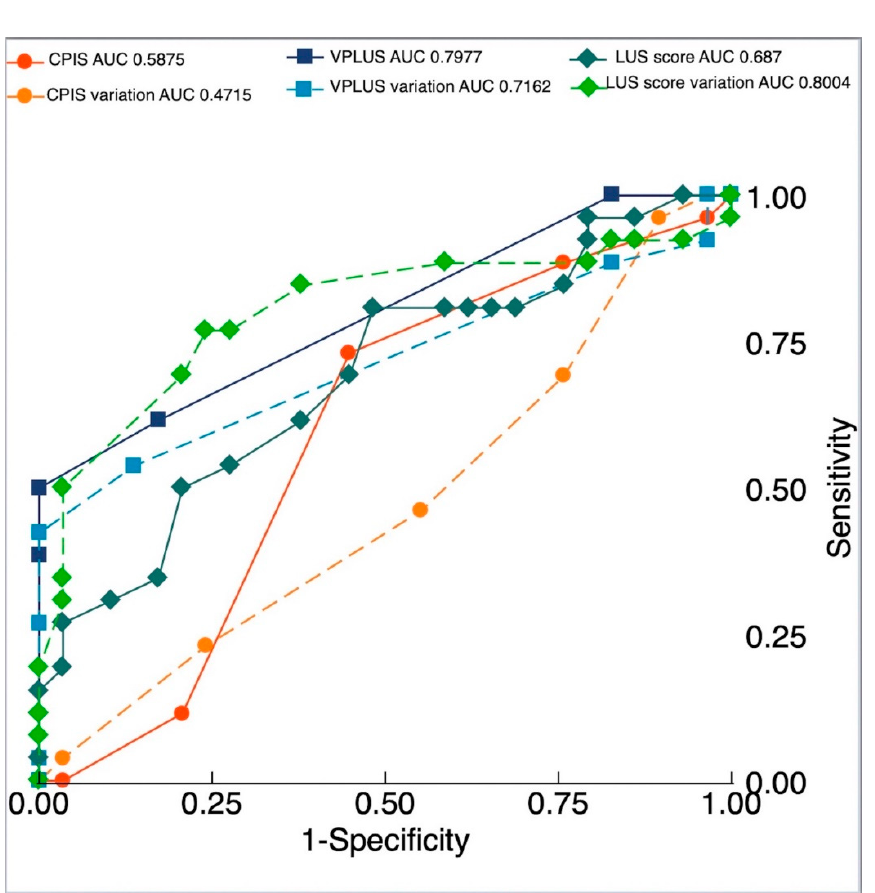
Figure 2. Diagnostic accuracy for clinical and ultrasound parameters, areas under the receiver operating characteristic curves generated for clinical pulmonary infection score (CPIS), CPIS variation, ventilator-associated pneumonia lung ultrasound score (VPLUS), VPLUS variation, lung ultrasound (LUS) score, and LUS score variation.